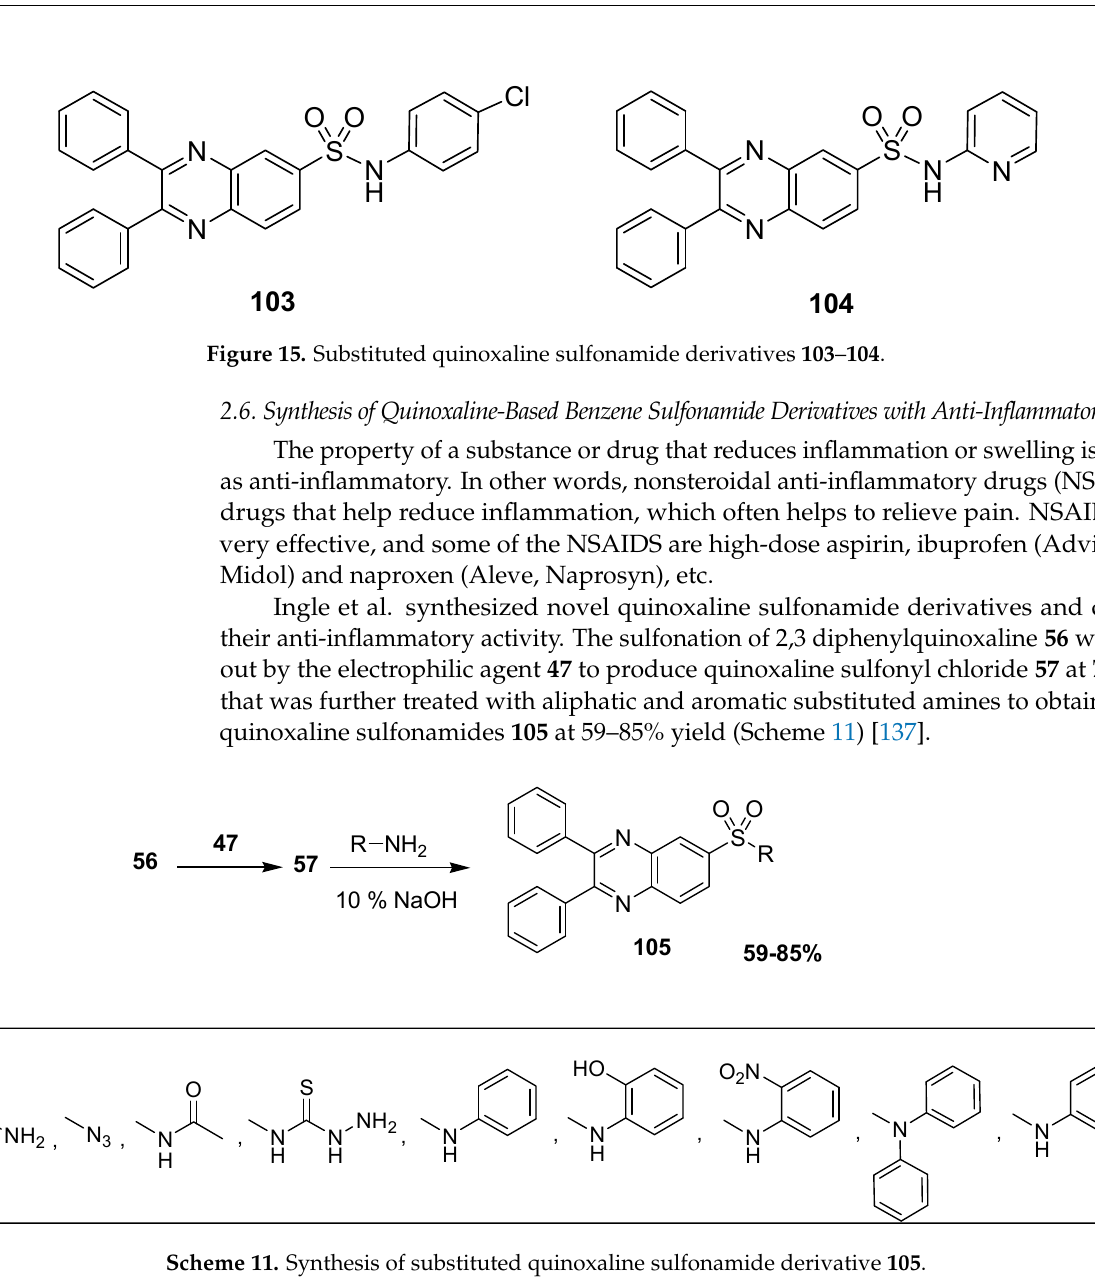
Figure 16. Substituted quinaxoline sulfonamide derivatives 106–108.